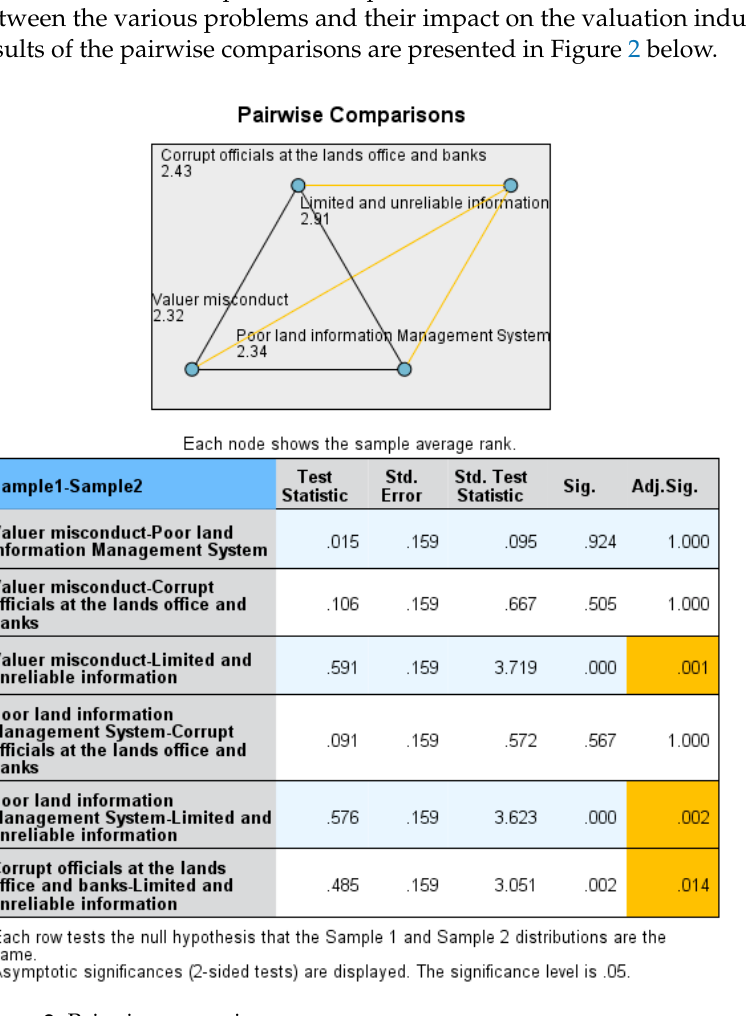
Figure 2. Pairwise comparisons.